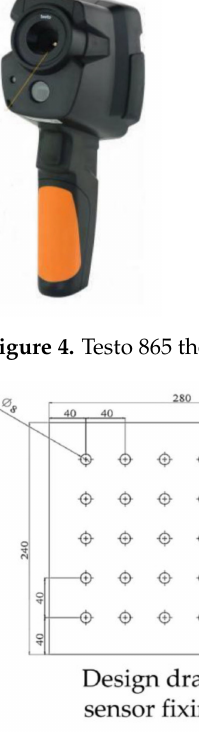
Figure 5. PT100 thermocouple